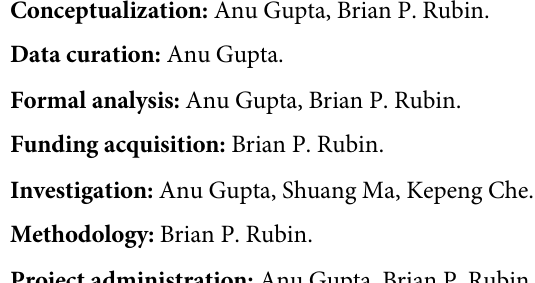
nM) and combinations thereof as indicated for 48 h before measuring the caspase 3/7 activity. Data is presented as percentage of control and each column represents mean of triplicates. Each point represents mean ± standard error, n = 3. The data is representative of three differ- ent experiments. p values for various combinations were compared within each KIT inhibitor treatment group. ( ��� p < 0.0001). S5 Fig. Drug combinations with trametinib decrease the colony-forming ability of GIST cell lines. (A) Colony outgrowth (clonogenic) assay to assess the treatment response of imati- nib-sensitive (GIST-T1) and -resistant (GIST-T1/670, GIST-T1/10R) cell lines to trametinib (TR) and the indicated drug combinations. After drug treatment, the cells were allowed to form colonies in drug-free media for two weeks before staining with crystal violet. (B) Quanti- fication of colony numbers from the clonogenic assay, the colony numbers were normalized to the vehicle controls (Cont) and each column represents mean of triplicates. The experiment was repeated three times and representative data is shown. Each point represents mean ± standard error, n = 3. The data is representative of three different experiments. p val- ues for various combinations were compared within each KIT inhibitor treatment